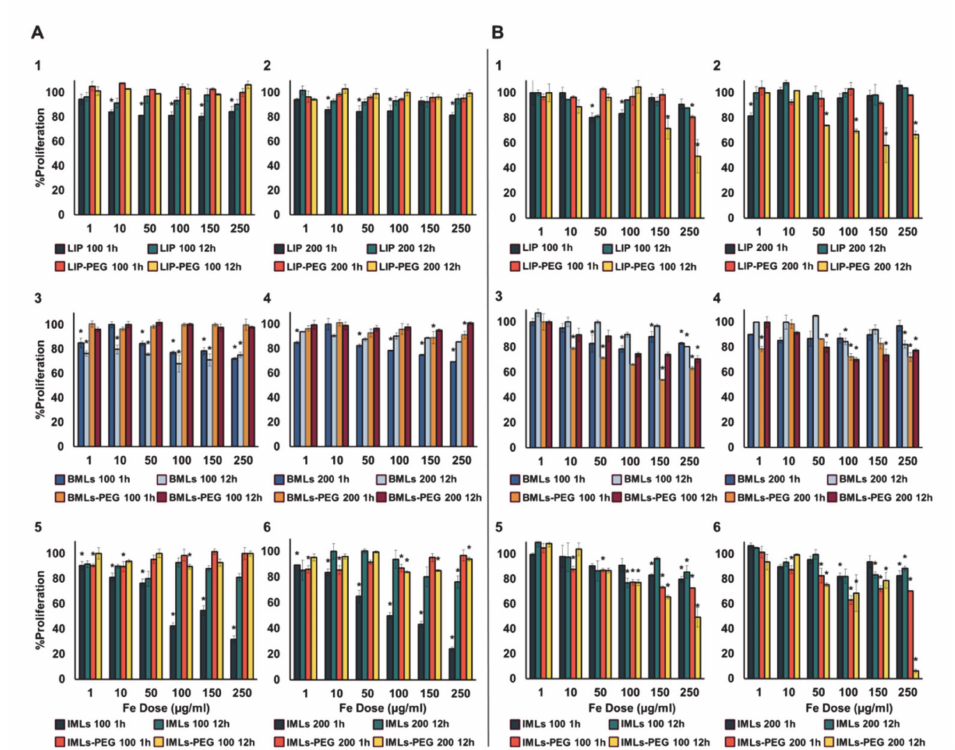
Figure 3. Toxicity test in human white blood cells (WBC) ( A ) and RAW 264.7 macrophages ( B ). Data represent the mean values ± SD of triplicate samples. Statistically significant di ff erences with respect to untreated control ( p < 0.05) are represented with